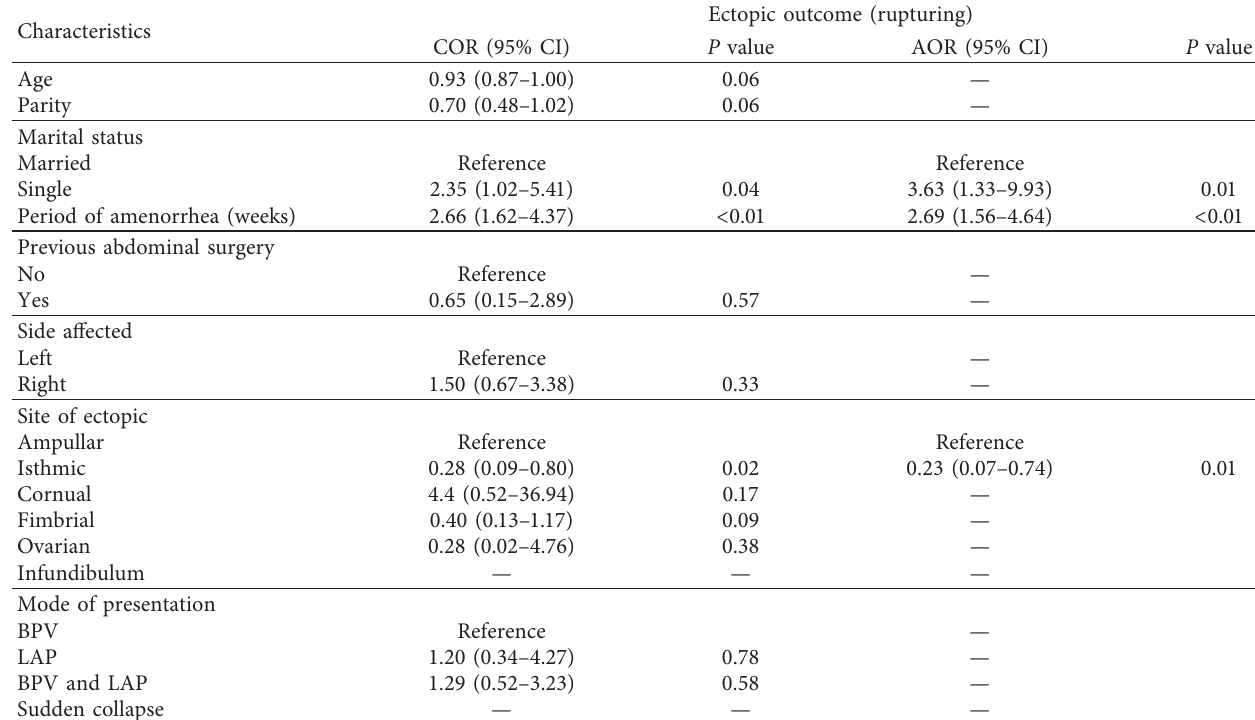
Table 3: Characteristics associated with ectopic outcome